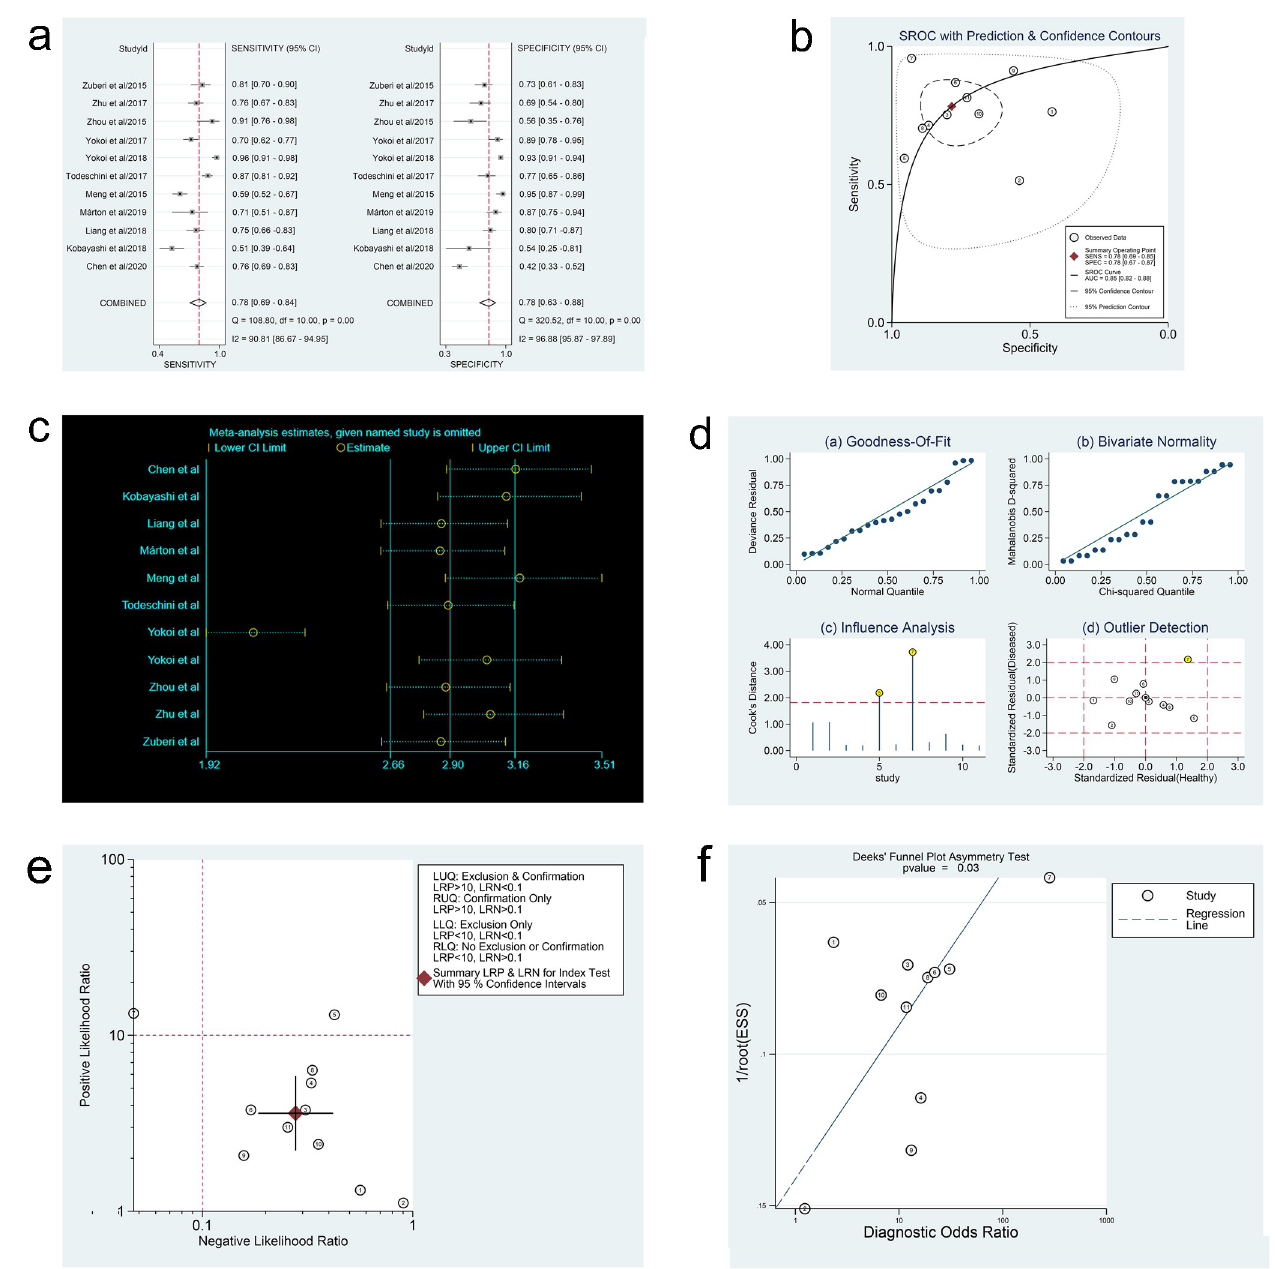
Fig 3. Forest plots of sensitivity and specificity, SROC curve, sensitivity analysis plot, goodness-of-fit and bivariate normality analysis plots, likelihood ratio plot and Deeks’ funnel plot of miRNAs. (a) Forest plots of sensitivity and specificity to evaluate the diagnostic performance of miRNAs. (b) SROC curve to describe the diagnostic value of miRNAs. (c) Sensitivity analysis to estimate each study’s value of miRNAs. (d) Goodness-of-fit and bivariate normality analysis plots to explore the sources of heterogeneity of miRNAs. (e) Likelihood ratio plot to appraise the diagnostic and elimination capabilities of miRNAs. (f) Deeks’ funnel plot to assess publication bias of